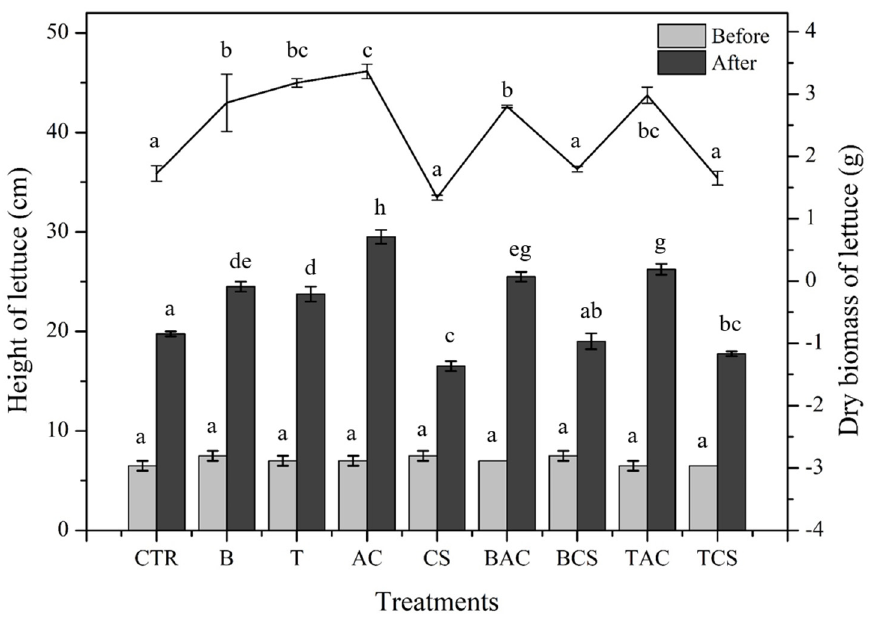
Figure 5. Plant growth at various amendment treatments after 45 days. Means with the same letters are not significantly different from each other under different amendment treatments according to Tukey’s test ( p < 0.05, n = 3) (CTR: control, B: bentonite, AC: activated carbon, CS: cornstarch).